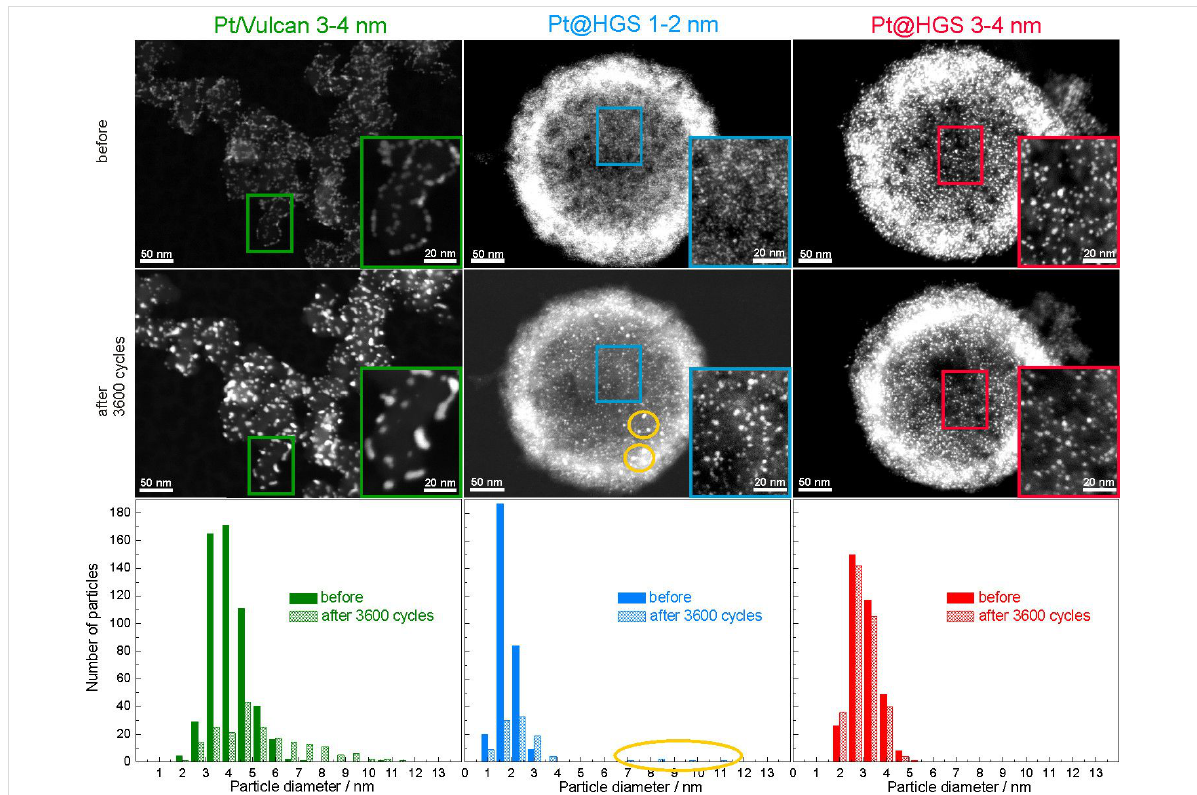
Figure 5: Identical location dark field IL-STEM of Pt/Vulcan 3–4 nm (green), Pt@HGS 1–2 nm (blue) and Pt@HGS 3–4 nm (red) after 0 (top) and after 3600 (middle) potential cycles between 0.4 and 1.4 V RHE in 0.1 M HClO 4 at a scan rate of 1 V·s − 1 at room temperature. The insets highlight sub- regions in the micrograph. The yellow circles for the Pt@HGS 1–2 nm material mark several particles which result from untypical, strong particle growth. The change in particle size distribution for all three Pt/C materials is additionally depicted at the bottom. Bars referring to the same particle diameter before (filled) and after degradation (shaded) are pictured next to each